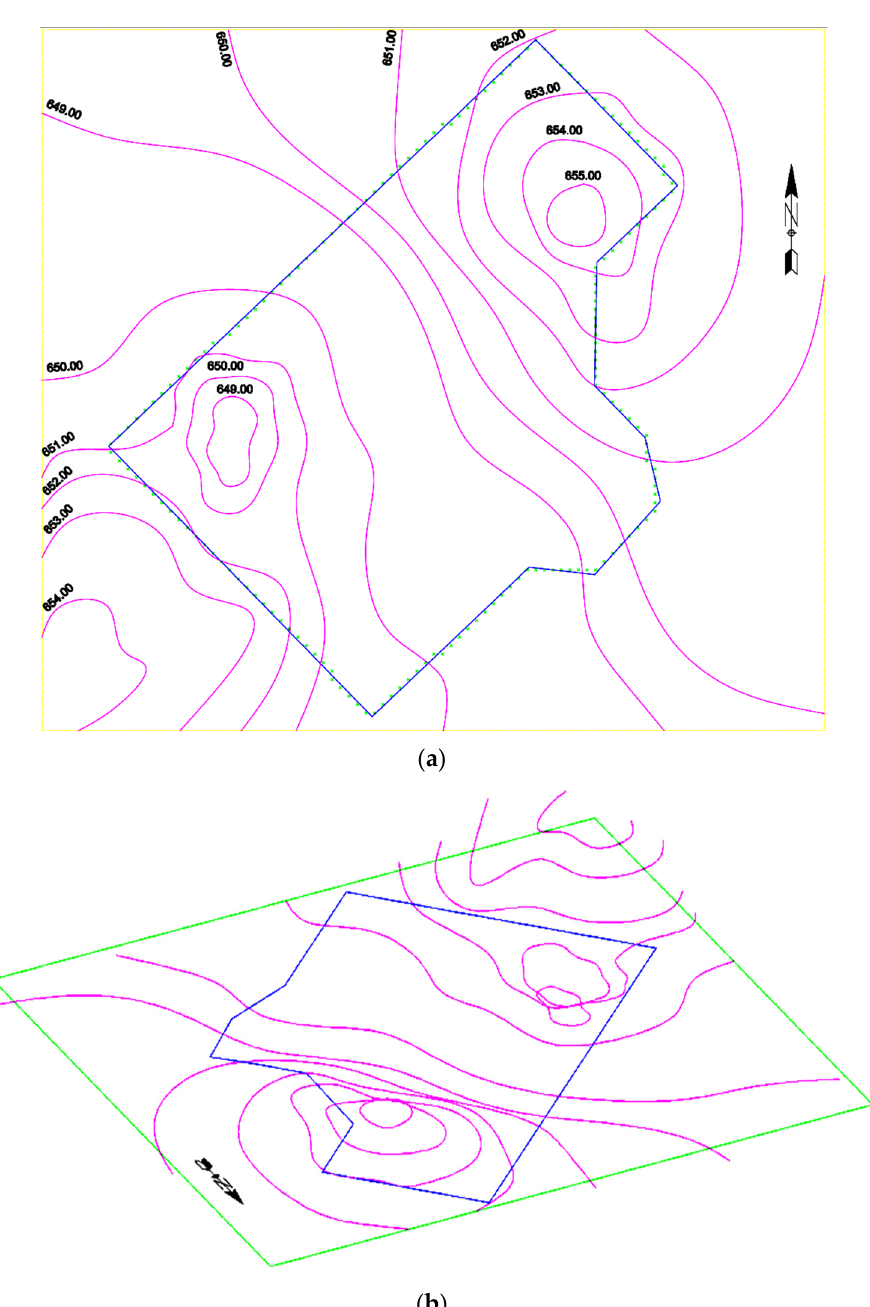
Figure 8. Level curves (pink lines) in the vicinity of the house (blue lines): ( a ) 2D view; ( b ) 3D view.